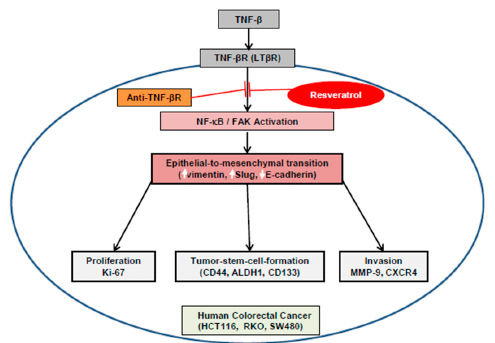
Figure 7. Graphic reveals resveratrol-modulated anti-cancer activity by suppressing TNF- β /TNF- β R in CRC cells.